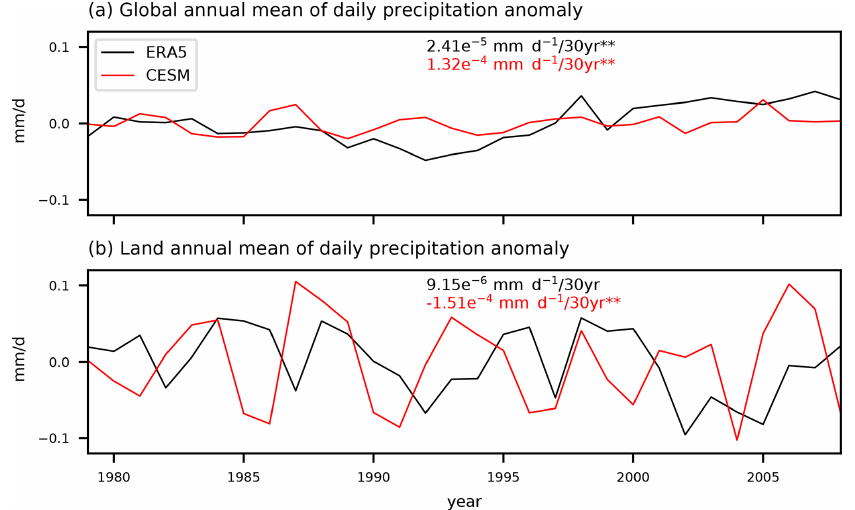
Figure 4. Time series of annually averaged mean daily precipitation over the (a) entire globe and (b) land only in ERA5 (black) and CESM (red). The values on the figures indicate the trends and ** denotes that the trends are statistically different to zero at the 99% confidence interval based on the Mann–Kendall trend tests.